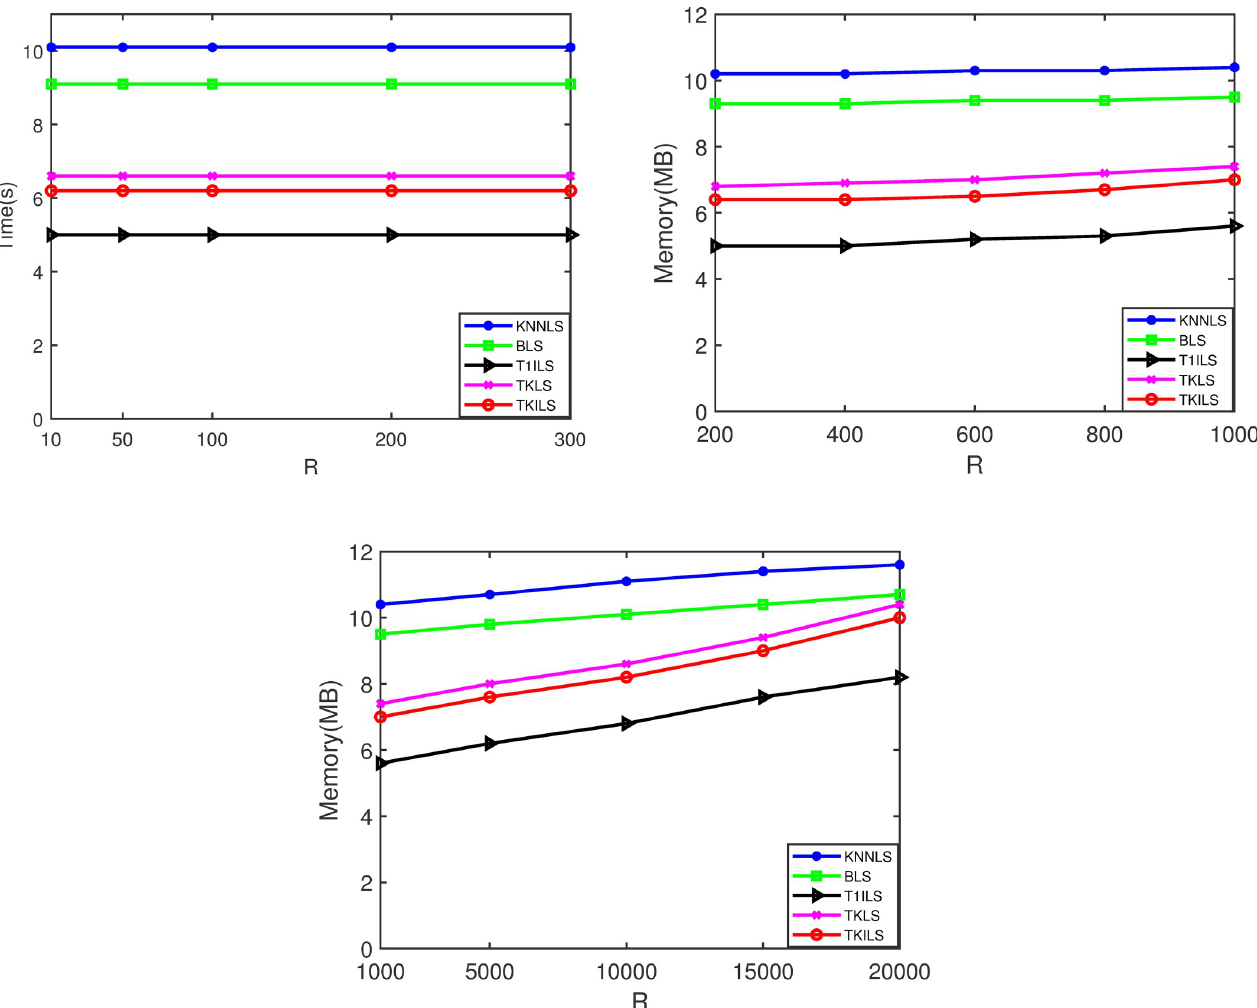
Fig 11. Running memory of the algorithms. Note: Fig 11(A)–11(C) are the running memory results for varying | R | from 10 to 20000 on the real datasets,